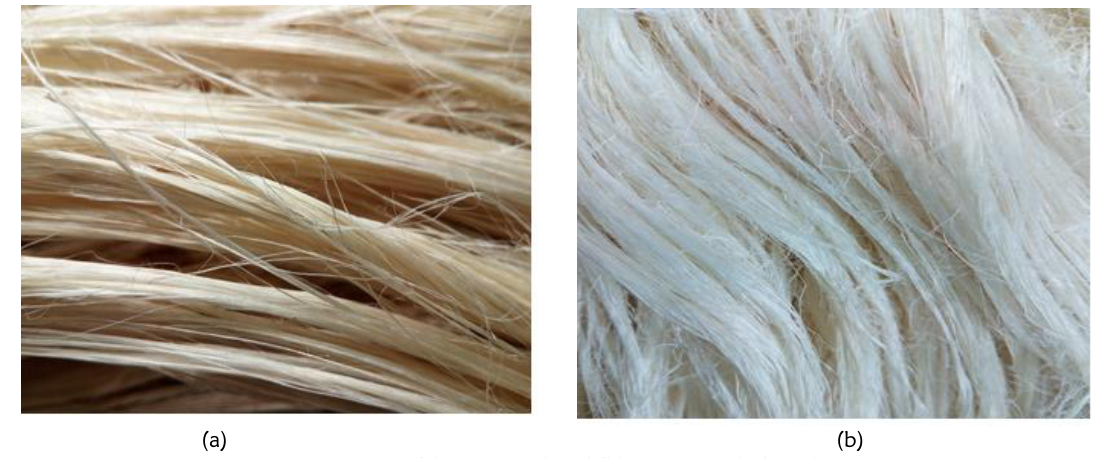
Figure 1: (a) Untreated and (b) Mercerized okra